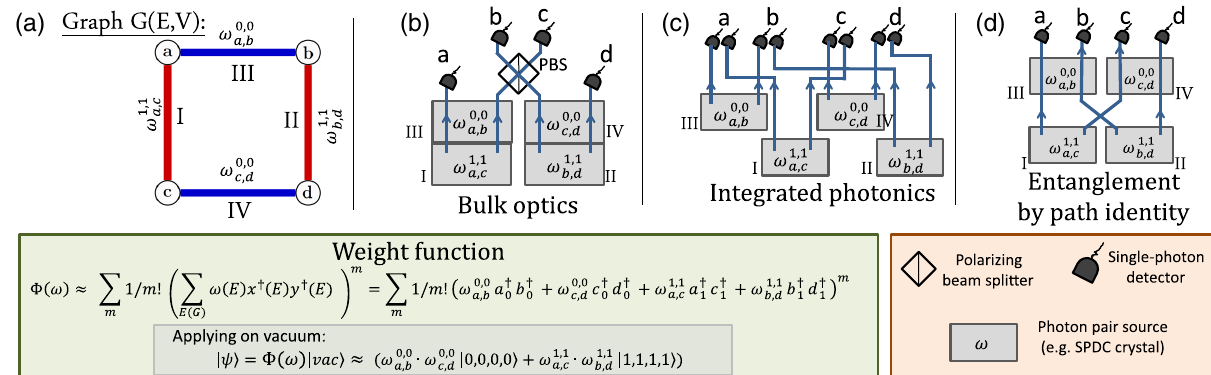
FIG. 1. A weighted edge-colored graph as an abstract and efficient representation of the quantum information of a large variety of quantum optics experiments. (a) As a specific example, we show a graph with four vertices and four colored and weighted edges. The vertices a – d correspond to photonic paths, the edges correspond to correlated photon pairs, the edge colors stand for mode numbers, and weights ω ∈ C stand for complex coefficients. Probabilistic sources create the photon pairs (edges). Thus, the entire information about the quantum state is represented by Φ ð ω Þ , with x † being a creation operator of a photon in path x with mode number k . The graph can k directly be translated into a number of different quantum optical technologies, such as (b) standard bulk optics, for example, with polarization encoding, or (c) path encoding as the carrier of quantum information or (d) entanglement by path identity. In all examples, the gray squares I – IV stand for probabilistic pair sources (such as nonlinear crystals which create photon pairs using spontaneous parametric down-conversion). Two crystals in a row, such as in (b), is a standard tool for generating photonic entanglement, denoted cross-crystal sources [43,44]. Two of the four crystals produce a photon pair. Blue lines show the path of the photon pair from the crystal to the photon detectors a – d . We show a number of examples in the Appendix A and provide an open-source code for the translation. The results of the quantum experiments can directly be calculated from the information of the graph. For example, a prominent technique is to condition the state on detecting a photon in each of the four detectors (postselection). The equivalent formulation in terms of graphs is the sum of all subsets of edges that contain every vertex exactly once, which is called perfect matching. It reduces the example quantum state to two terms. If all weights are equal, the resulting quantum state is a four-qubit GHZ state. Access to Φ ð ω Þ allows for the optimization of nonpostselected, heralded, and triggered quantum states, too, as we show in examples within the